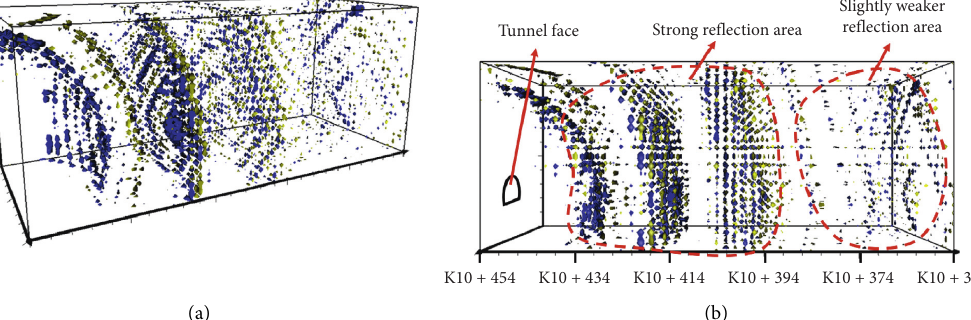
Figure 6: 3D image of seismic wave reflection scanning imaging. (a) General view of seismic reflection imaging. (b) Side view of seismic reflection